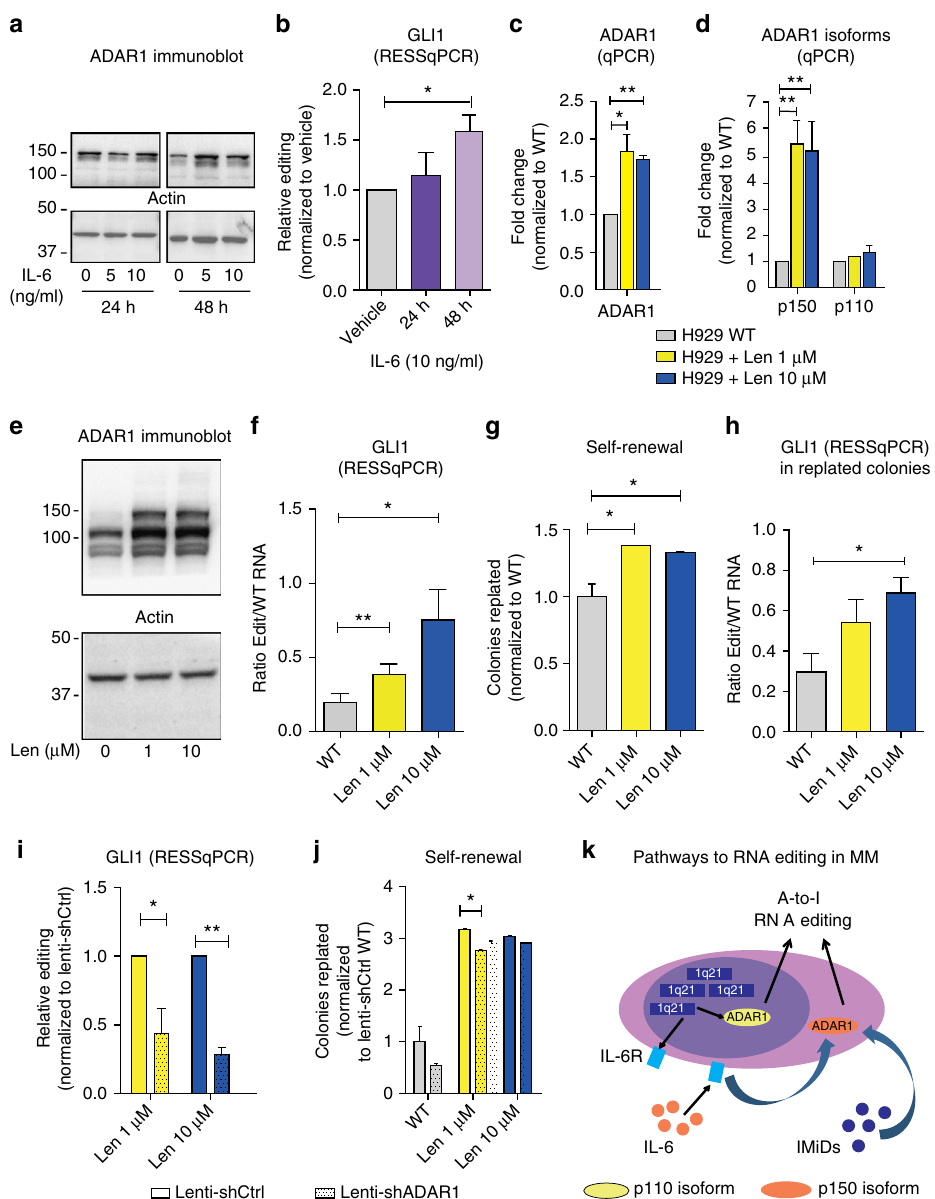
Fig. 4 MM-niche-derived cues trigger ADAR1 expression and activation. a Representative Western blot analysis of wild-type (WT) H929 cells after IL-6 stimulation. Upper blot: anti-ADAR1 monoclonal antibody reveals bands at 150 kDa, corresponding to isoform p150, at 24 h (left panel) or 48 h (right panel), after IL-6 stimulation in H929, compared to vehicle control. Bottom blot: actin for normalization. b GLI1 RNA editing by RESSq-PCR in IL-6- stimulated cells after 24 – 48 h, normalized to vehicle control. Histograms represent mean ± S.E.M. of at least three independent experiments. c ADAR1 increased mRNA expression in lenalidomide-treated (1 μ M, 5 – 50 weeks; 10 μ M, 5 – 40 weeks) H929 cells compared to WT. d ADAR1 isoform expression in lenalidomide-treated H929 versus WT. Histograms represent mean ± S.E.M. values of at least three independent experiments. * p < 0.05, ** p < 0.01 by unpaired, two-tailed Student ’ s t -test. e Representative Western blot analysis of H929 cells under prolonged lenalidomide treatment. Upper blot: anti- ADAR1 polyclonal antibody reveals two bands at 150 kDa and 110 kDa corresponding to isoforms p150 and p110 in lenalidomide-treated cells (1 μ M Len, 20 weeks; 10 μ M Len, 10 weeks). Bottom blot: actin for normalization. f GLI1 mRNA editing in lenalidomide-treated H929 (1 μ M; 10 μ M) compared to WT by RESSq-PCR in at least three independent qPCR experiments. * p < 0.05, ** p < 0.01 by unpaired, two-tailed Student ’ s t -test. g Colony formation assays of Len-resistant H929 versus WT (mean ± S.E.M., n = 3 per condition). Histograms show relative colony replating capacity compared to WT; * p < 0.05 by unpaired two-tailed Student ’ s t -test. h GLI1 RNA editing by RESSq-PCR in replated colonies from Len-resistant H929 versus WT (mean ± S.E.M., n = 3 per condition); * p < 0.05 by unpaired two-tailed Student ’ s t -test. i GLI1 RNA editing by RESSq-PCR after silencing (Lenti-shCtrl versus Lenti-shADAR1) in lenalidomide-resistant H929 cells. Histograms show mean ± S.E.M. * p < 0.05, ** p < 0.01 by unpaired, two-tailed Student ’ s t -test. j Self-renewal of Len- resistant versus WT H929 upon lentivirally-enforced silencing of ADAR1. Histograms show relative colony replating compared to shCtrl WT (mean ± S.E.M., n = 3 per condition). * p < 0.05 by unpaired two-tailed Student ’ s t -test. k Schematic representation of ADAR1 > -RNA editing axis promoting drug resistance and tumor cell survival. Statistical signi fi cance was indicated when p < 0.05. See also Supplementary Figs. 4 and